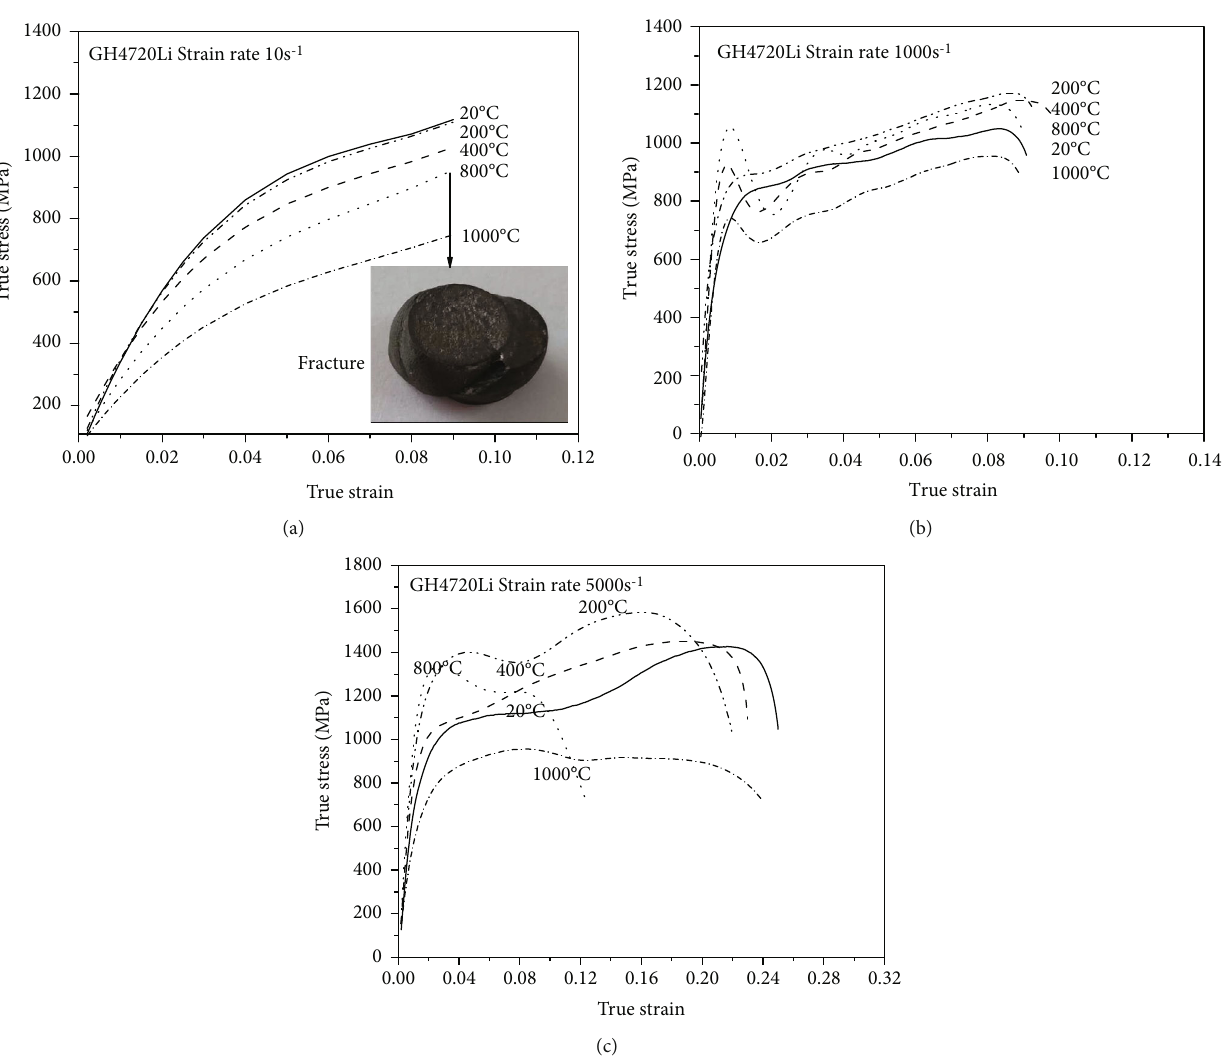
Figure 1: The true stress-strain curve of GH4720Li alloy under the di ff erent conditions (a) 10 s -1 , (b) 1000s -1 , and (c) 5000s -1